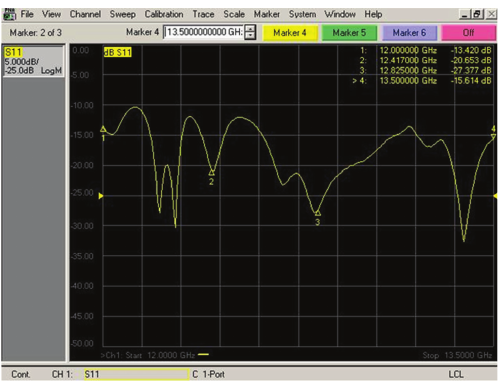
Figure 9: Network analyzer measurements as regards S 11.